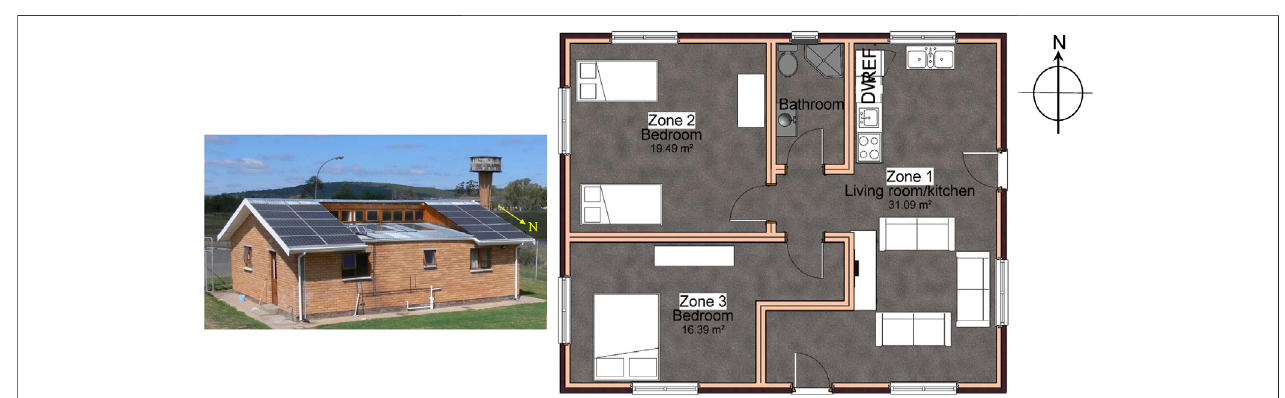
FIGURE 2 | Photo of the passive solar house used in the study and its fl oor